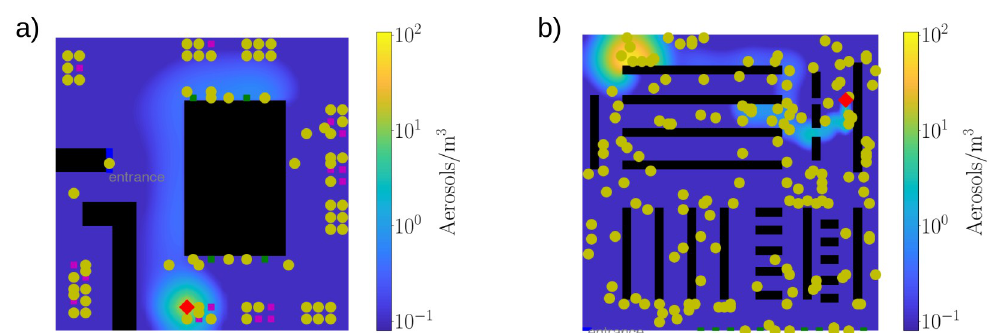
Fig 2. Snapshots from simulations in (a) bar and (b) supermarket environments. Healthy customers are depicted by yellow dots and infected customers by red diamonds, while the black regions are blocked, e.g. walls or shelves. In bar, the purple squares illustrate the seats available for the customers and the green squares are at the bar ‘counter’ where the agents get their next beverage. In supermarket, the green squares at the lower edge of the system are cashiers from where the customers leave the system. The colorbar shows the aerosol concentration in the systems. Opposed to the Wells-Riley model that assumes uniform distribution of infecting quanta, the aerosol concentrations in our model systems are non- uniform and highly dependent on the movement of the infected